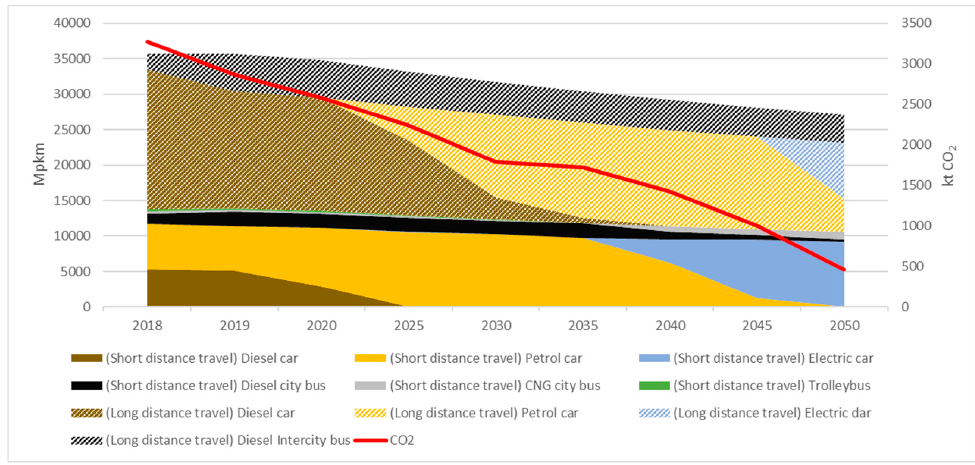
Figure 7. Distance traveled in MPkm by different transportation modes and CO 2 emissions from passenger road transport using a traditional modeling approach.